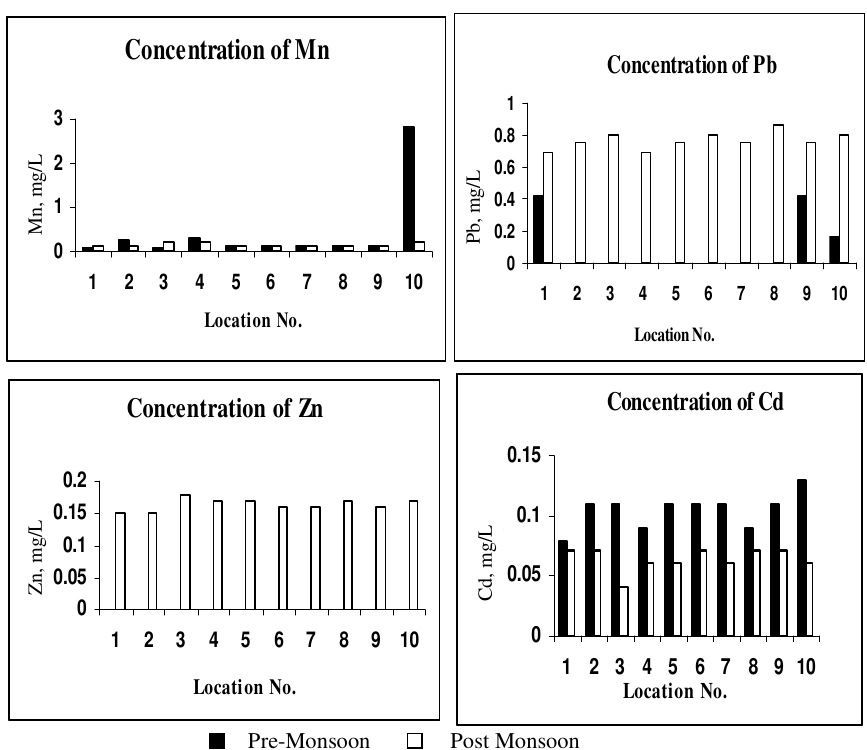
Figure 1. Seasonal variation of trace metal in Meenachil river